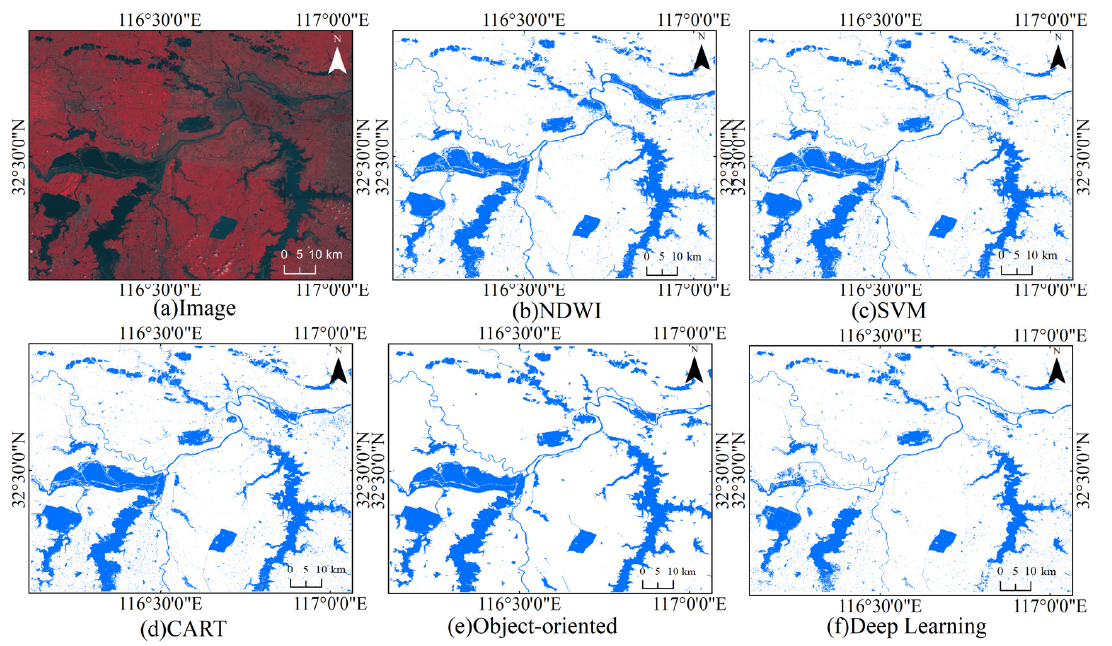
Figure 2. Water extraction results of several methods in the HuaiHe River Basin. ( a ) original image; ( b ) NDWI; ( c ) SVM; ( d ) CART; ( e ) Object-Oriented; ( f ) Deep Learning.